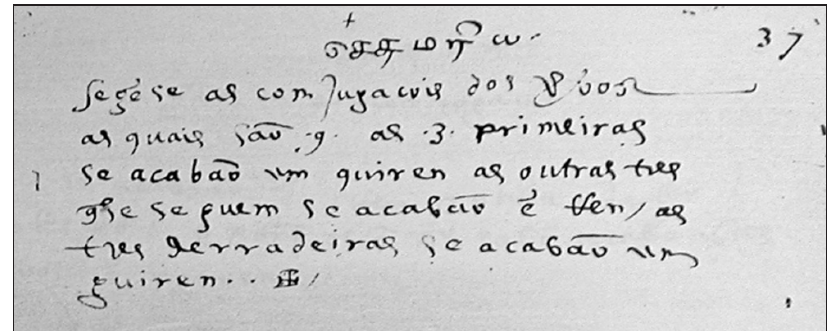
Figure 6: Extract from top of folio 37 r in Codex 3141 (BNP, Lisbon).